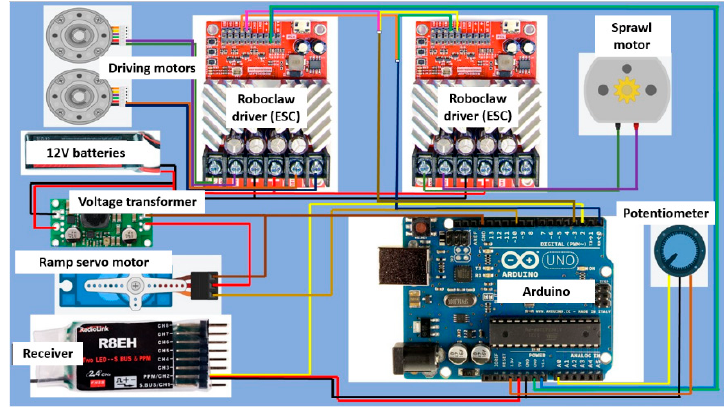
Figure 8. The control system of the robot is based on an Arduino Uno controller and two RobotClaw ECS controllers.